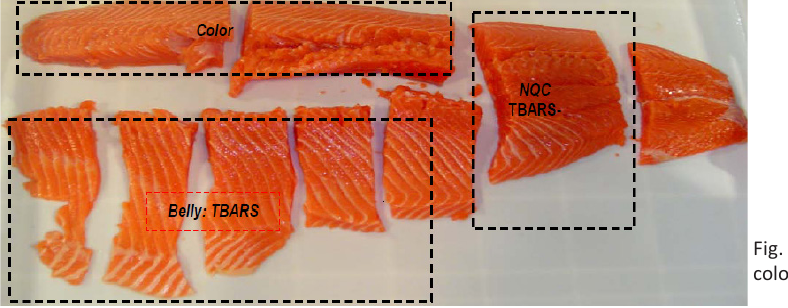
Fig. 1. Sampling zone for TBARS and color evaluation in trout